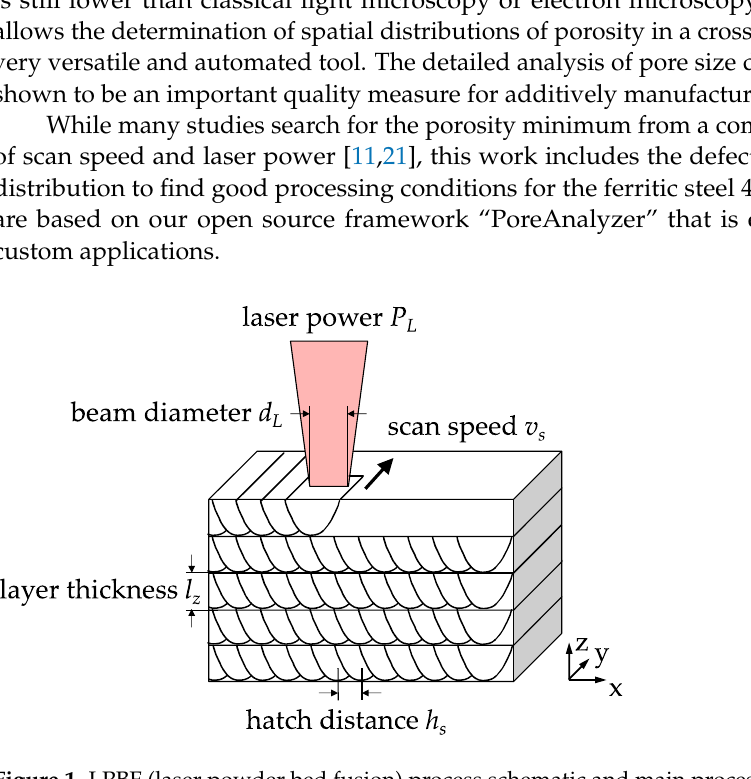
Figure 1. LPBF (laser powder bed fusion) process schematic and main process parameters.